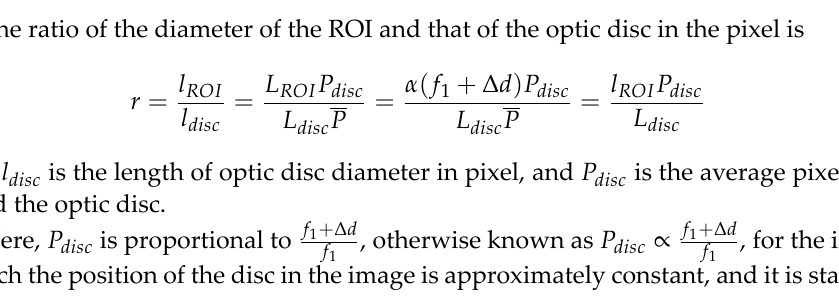
Figure 2. The image of a checkerboard captured by a fundus camera.